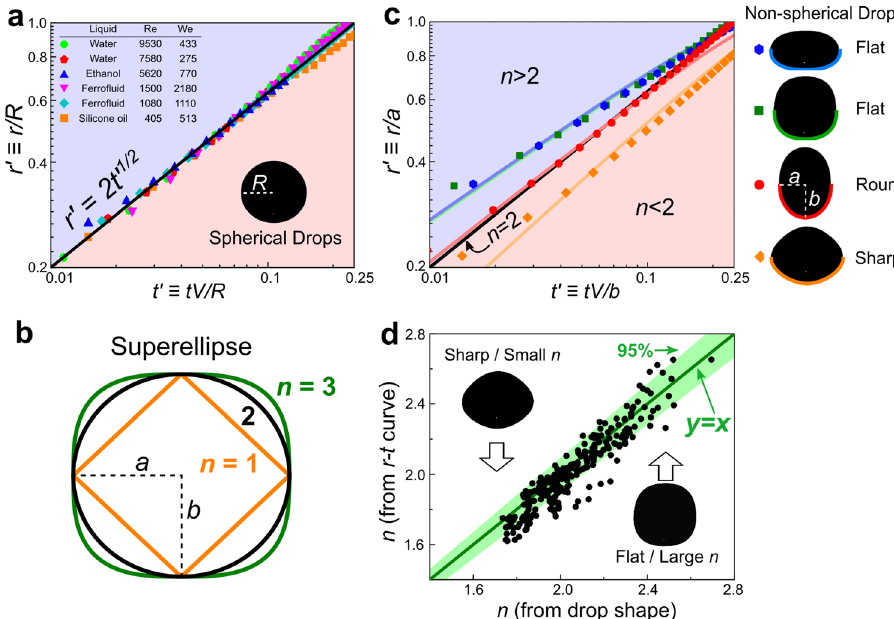
Fig. 2 The spreading dynamics explained by a superellipse model. a Dimensionless spreading radius versus time for spherical drops. The experimental data agree excellently with the theoretical scaling law, r ’ = 2t ’ 1/2 (the thick black line), for various liquids (including the ferro fl uid) and impact velocities. b The superellipse model. We construct a general model by fi tting a non-spherical shape to a superellipse: n = 2 is de fi ned as ‘ round ’ , n < 2 is de fi ned as ‘ sharp ’ , and n > 2 is de fi ned as ‘ fl at ’ . n is de fi ned as the sharpness, a and b are the semi-major and semi-minor axes. c Verifying the superellipse model with four non-spherical drop shapes. The colored symbols are experimental data for different shapes, and the colored curves are predictions from the superellipse model, Eq. (3), without any fi tting parameter. Four examples are shown: two n > 2 or ‘ fl at ’ examples are on the top, one n = 2 or “ round ” example is in the middle, and one n < 2 or “ sharp ” example is at the bottom. The two “ fl at ” examples have distinct outlooks: one is disc-like and the other is square-shaped (see the images at right). However, they exhibit almost identical spreading dynamics due to their similar sharpness n (blue and green symbols). The right panel shows the drop images and the colored curves at the bottom are the superellipse fi ttings. d A comprehensive test on our model with many drop shapes. X -axis is the n values directly measured from the drop shape before impact (Eq. (2)). Y -axis is the n values obtained by fi tting spreading dynamics to the superellipse model (Eq. (3)) after impact. Two sets of data are mostly within 95% con fi dence interval, which demonstrates an excellent